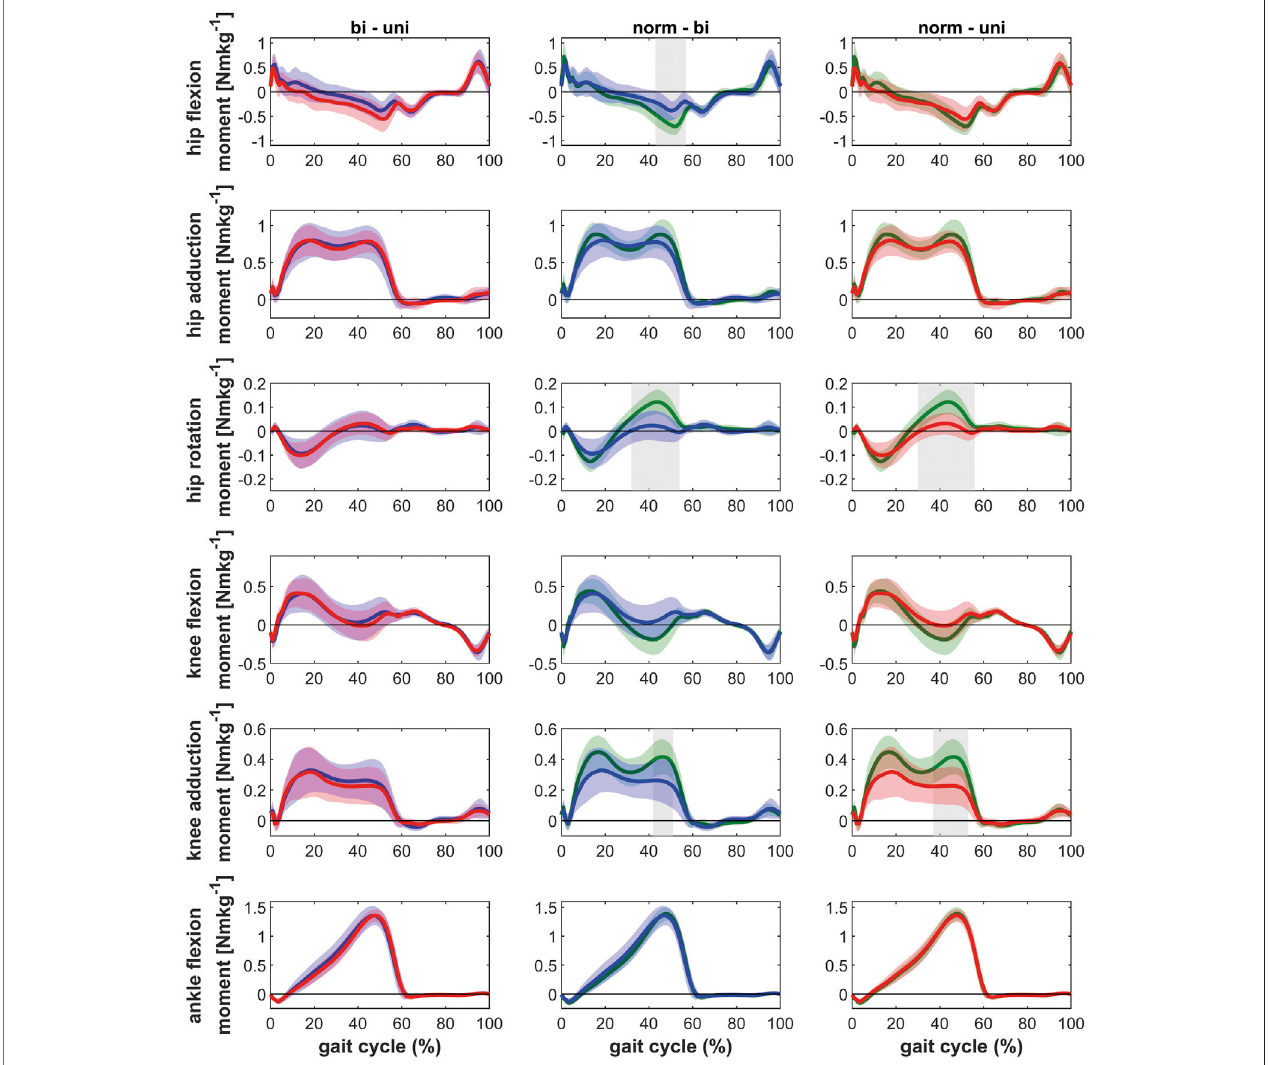
FIGURE 3 | Comparison of the kinetics of the ipsilateral leg between bilateral hip OA patients, unilateral hip OA patients and healthy controls. Mean and one standard deviation of the external joint moments. Shaded areas indicate statistical differences. Blue lines (cid:1) bilateral patients, red lines (cid:1) unilateral patients, green lines (cid:1) healthy controls. (A – C) hip fl exion/extension moment: fl exion (+)/extension ( − ); (D – F) hip adduction/abduction moment: adduction (+)/abduction ( − ); (G – I) hip rotation moment: internal rotation (+)/external rotation( − ); (J – L) knee fl exion/extension moment: fl exion (+)/extension ( − ); (M – O) knee adduction/abduction moment: varus (+)/valgus ( − ); (P – R) ankle dorsi fl exion/plantar fl exion moment: dorsi fl exion (+)/plantar fl exion ( −